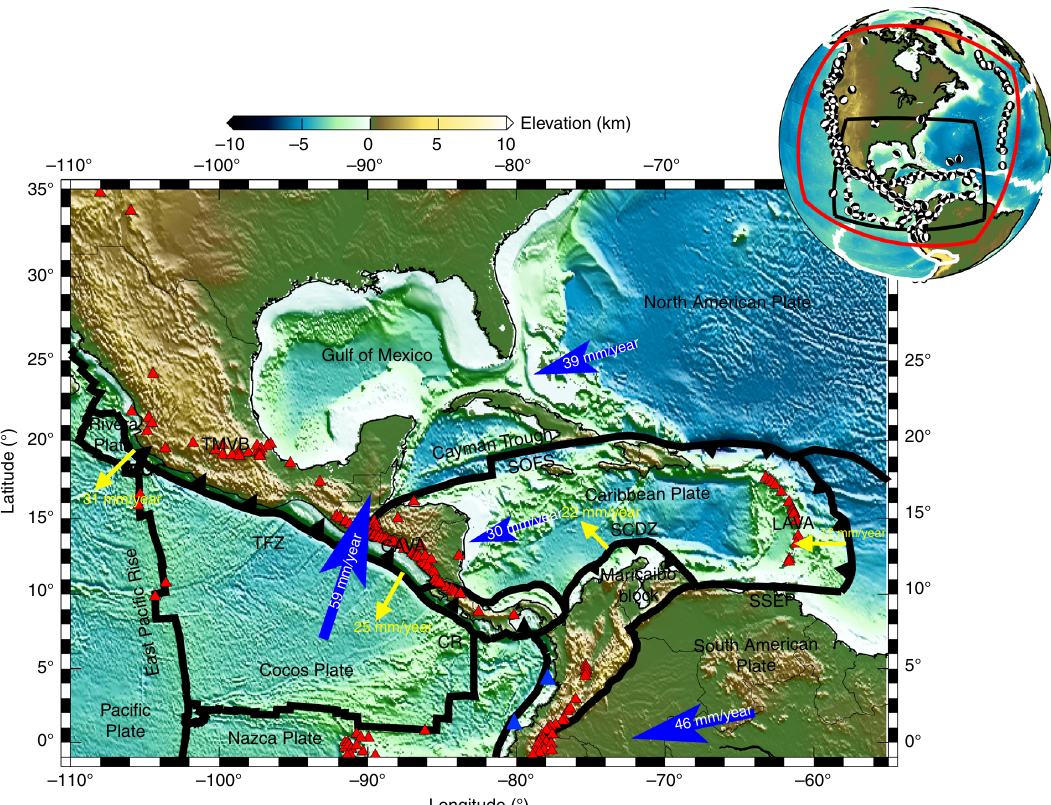
Fig. 1 Tectonic map for the Middle American and Caribbean Subduction Zones. Black lines denote global plate boundaries with triangles showing subduction directions 87 . Red triangles are volcanoes (www.ngdc.noaa.gov/hazard). Blue arrows denote plate motion directions 58 , and yellow arrows show trench migration velocities 55 , all with the Paci fi c hotspot reference frame. The top right insert shows the location of the study region, with the red box showing the inversion domain. Beach balls denote the moment tensor solutions for earthquakes used in the inversion (www.globalcmt.org). Abbreviations for tectonic structures are: CAVA Central American Volcanic Arc, CR Cocos Ridge, EGG El Gordo Graben, LAVA Lesser Antilles Volcanic Arc, SCDZ Southern Caribbean Deformation Zone, SOFS Septentrional-Oriente Fault System, SSEP San Sebastian-El Pilar Fault System, TFZ Tehuantepec Fracture Zone, TMVB Tran-Mexico Volcanic